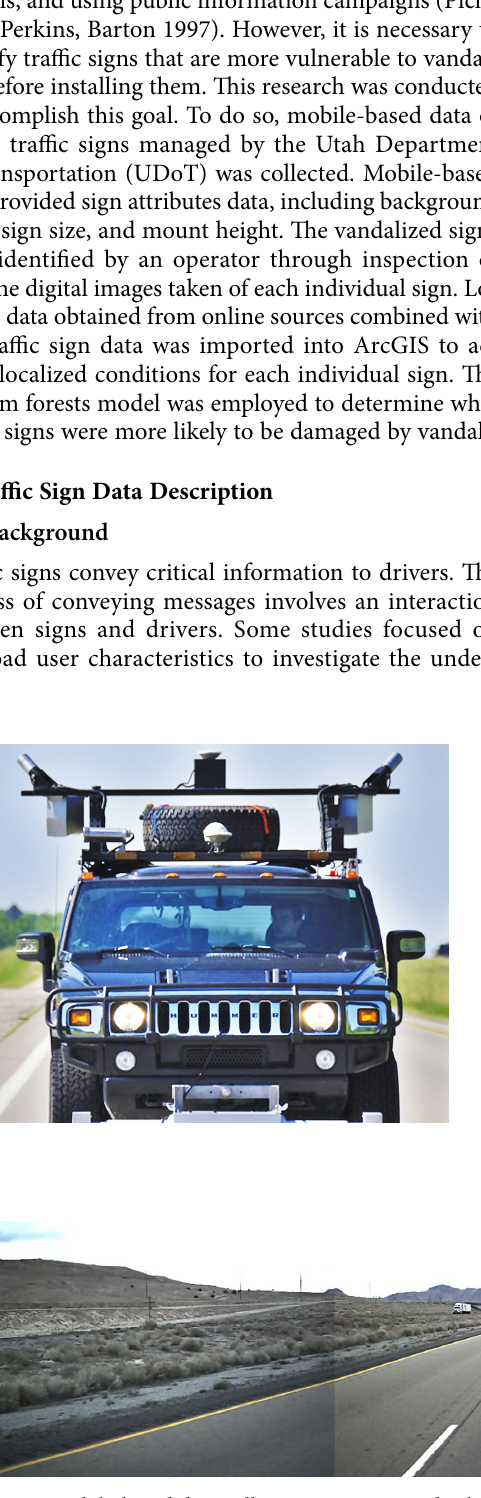
Fig. 1. Mobile-based data collection: a – equipped vehicle (source: http://mandli.com ); b – taking image of traffic signs (source: http://168.178.125.102/roadview.asp?Route=0080P &